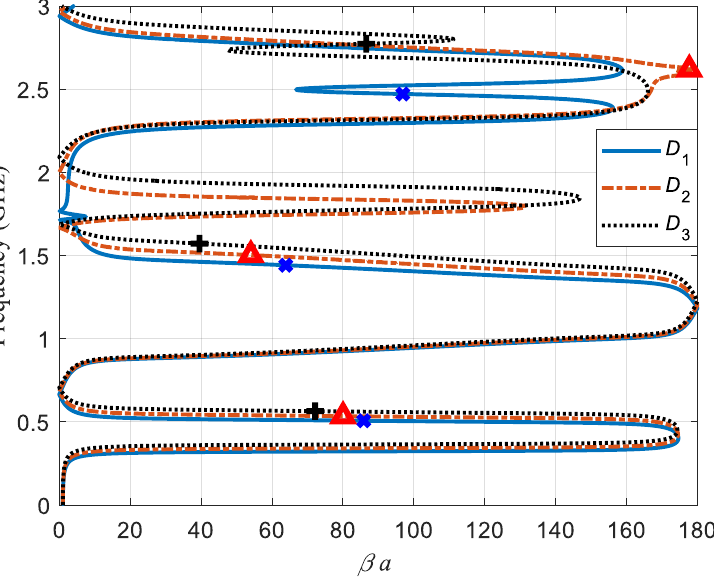
Figure 3. Dispersion relations of the sensor for configurations D 1 (blue solid line), D 2 (red dashed line), and D 3 (black dotted line). Blue x symbols, red ∆ symbols, and black + symbols are placed at the resonant frequency values for the three first modes of configuration D 1 , D 2 , and D 3 , respectively. The dispersion relation reveals forward and backward propagation zones. Between 1.5 GHz and 3 GHz, there are several changes in the direction of propagation and some of them in a very abrupt way, in this zone, which is where the sensor might be more perceptible of small changes in its environment. Dispersion relations were found using the scattering parameters S , which were simu- lated using a full-wave simulator [17], as described in Reference [18]. β a is the propagation constant for the sensor. It can be noted that, for some frequency regions, there is a for- ward propagation and the other propagation is backwards. Blue x symbols indicate the corresponding frequency and propagation constant values for the three modes of the D 1 configuration, as well as red ∆ symbols and black + symbols for D 2 and D 3 configurations, respectively. All shown modes, aside from the third mode of D 2 and D 3 configurations, have a backward propagation. At 1.7 GHz, there is a small flange for the D 1 curve, and the region between 1.6 GHz to 2.1 GHz has no β a values bigger than 1.7 of a degree per unit cell. The propagation constant starts as forward propagation, but, suddenly, changes to a left-handed propagation. This also happens for D 2 and D 3 , but they reach much higher values of β a . These values are 131 and 146 degrees per unit